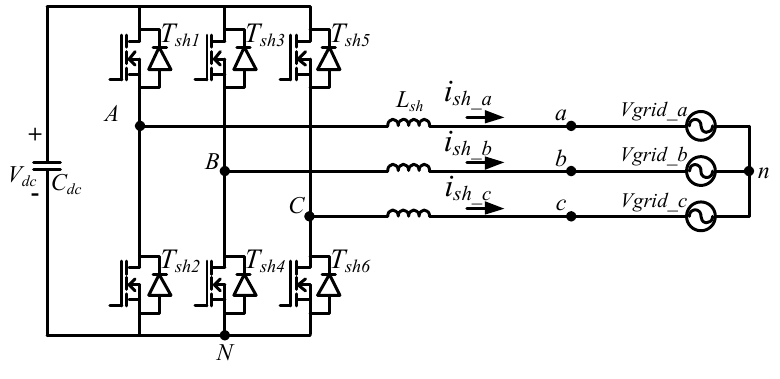
Figure 1. Shunt three-phase inverter.